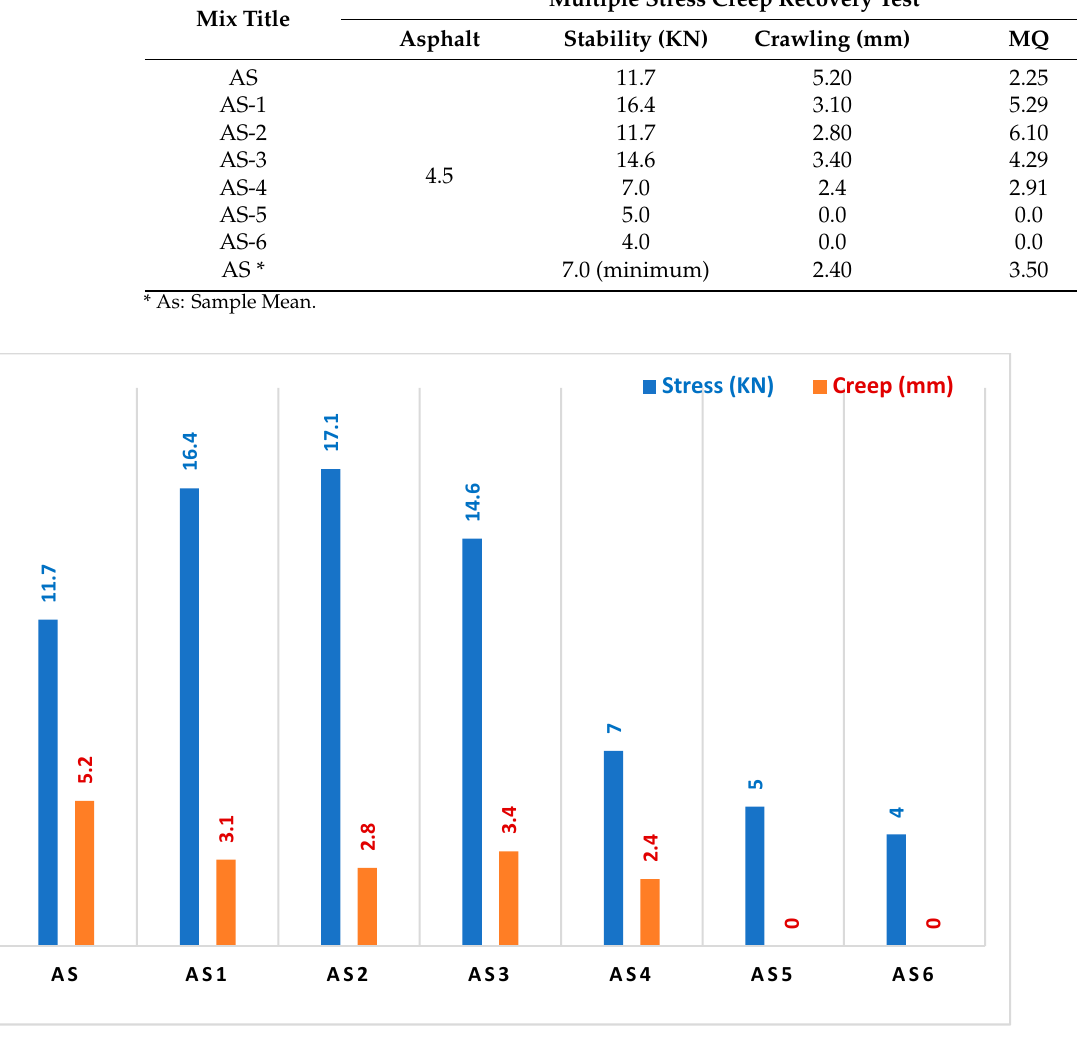
Figure 5. Multiple stress and creep recovery of PW and ULO-modified asphalt samples.